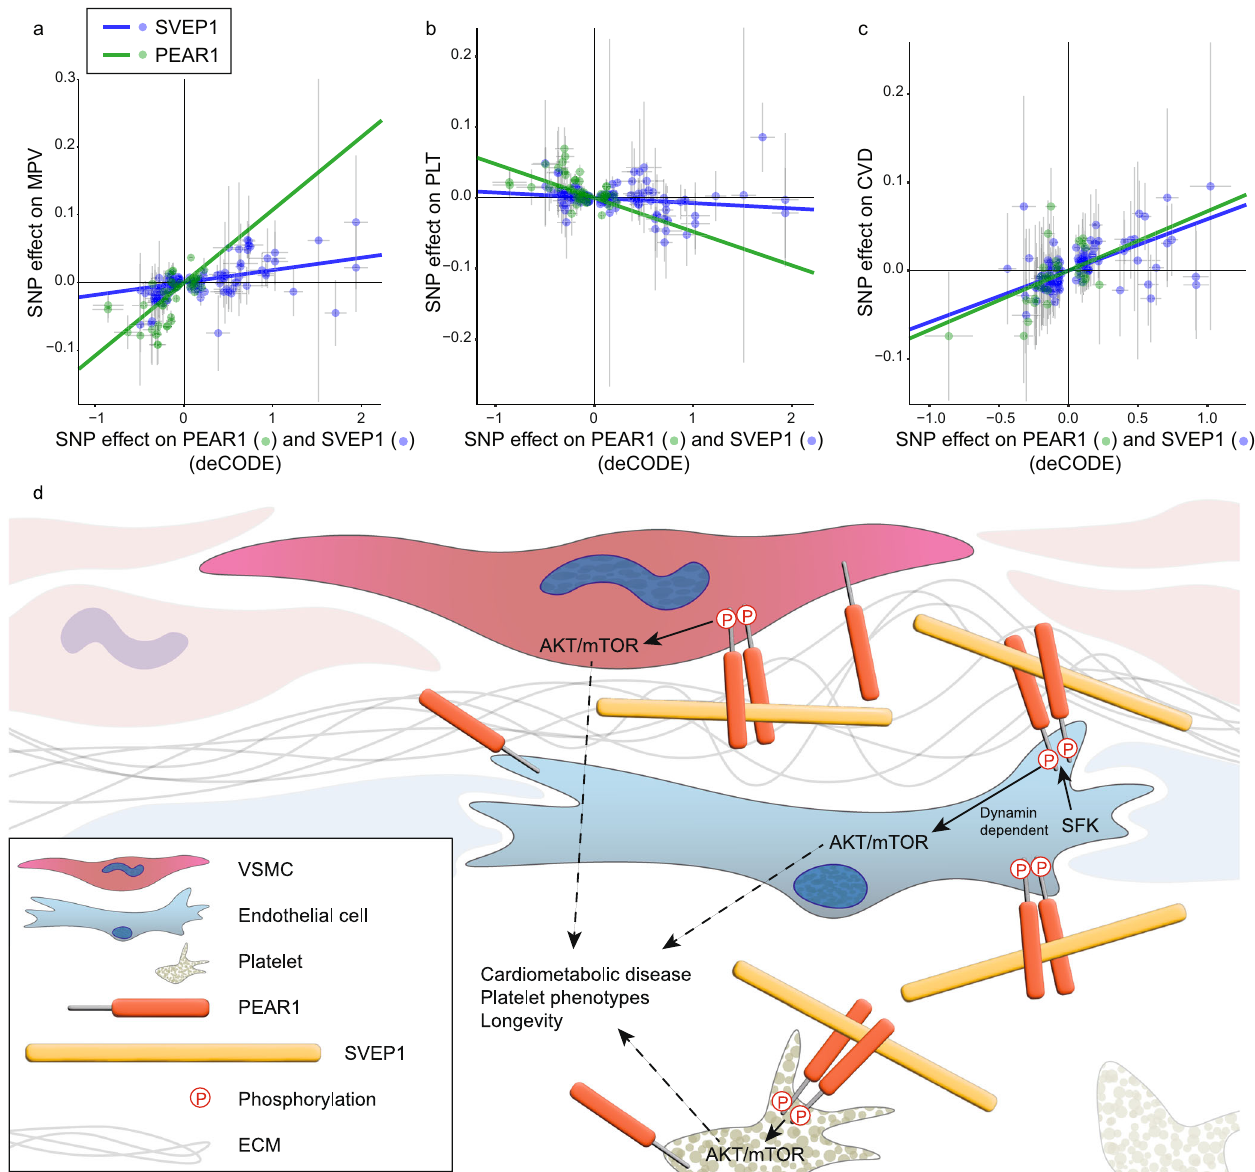
Fig. 6 | SVEP1 and PEAR1 causally and concordantly relate to human platelet traits and cardiovascular disease. a Two-sample MR of estimated SNP effects (with 95% con fi dence intervals) on MPV (y-axis) and either PEAR1, green, or SVEP1, blue, in deCODE ( x -axis). The causal estimate is designated by a line of the corre- sponding color. SVEP1 Beta=0.018, P =5.1×10 − 6 ; PEAR1 Beta=0.11, P =1.8×10 − 8 . b Two-sample MR of estimated SNP effects (with 95% con fi dence intervals) on platelet count ( y -axis) and either PEAR1, green, or SVEP1, blue, in deCODE ( x -axis). The causal estimate is designated by a line of the corresponding color. SVEP1